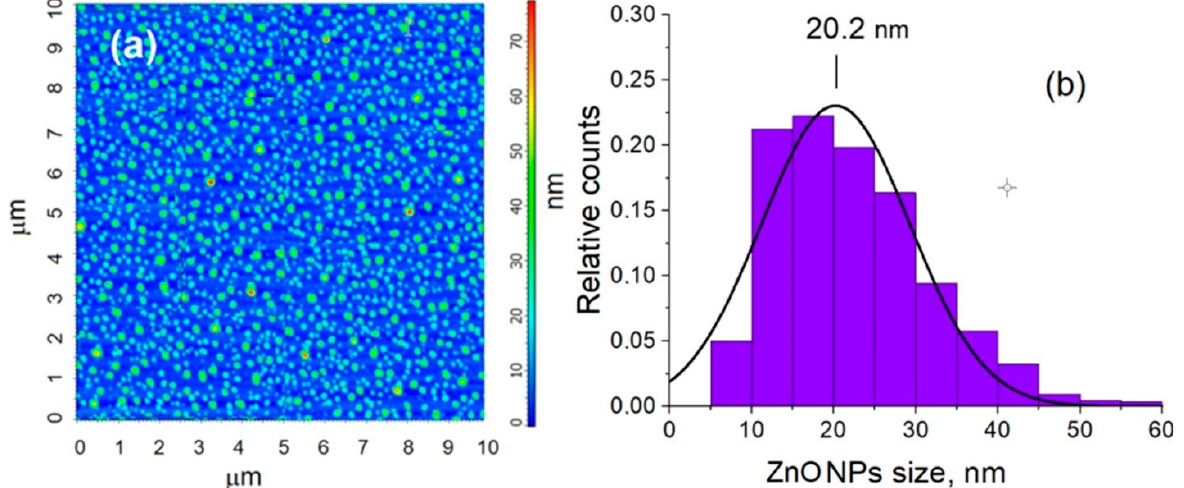
Figure 3. Atomic force microscopy-based analysis of ZnO nanoparticle solution: ( a ) Phase image of ZnO-NPs; ( b ) size distribution of ZnO-NPs.